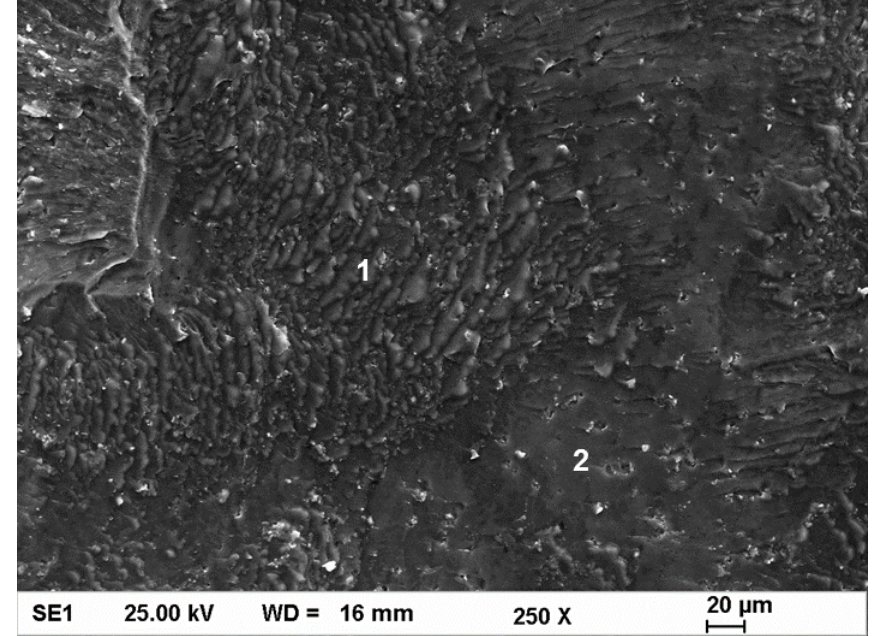
Figure 14. SEM image of a fracture surface of a AA 7020 and AZ 31B joint with silver interlayer on the aluminium side ( 1 ) presumably Al 3 Mg 2 containing traces of silver and zinc and ( 2 ) aluminium base material with traces of magnesium.